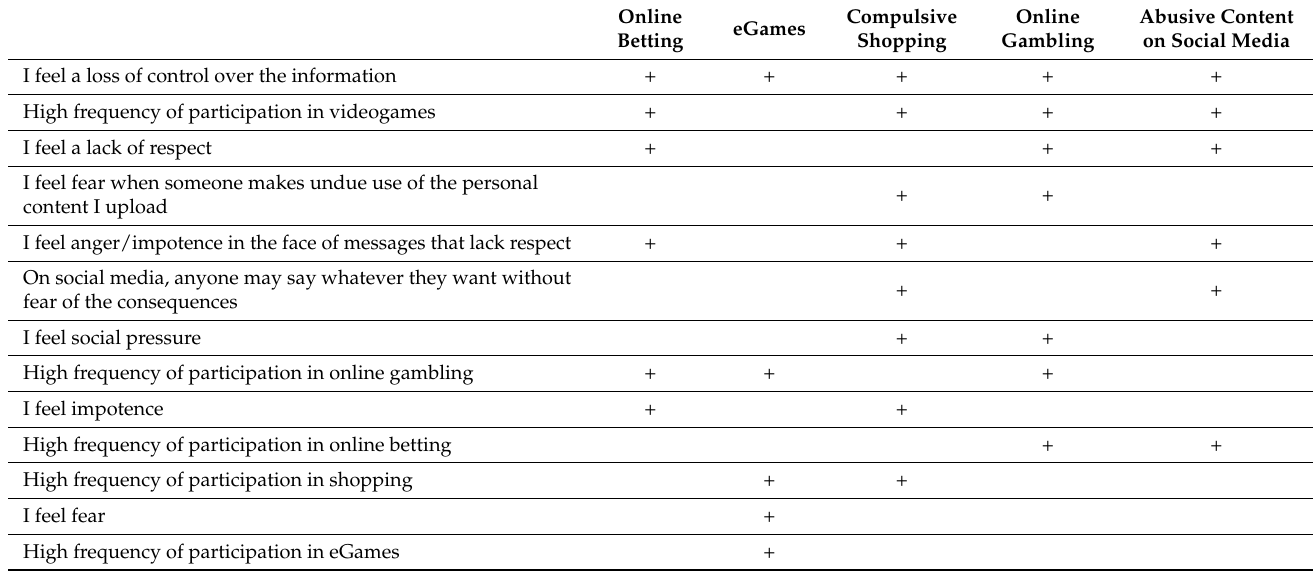
Table 7. Variables whose values indicating the presence of the value measured increase the probability of perceiving risk or danger in risky online activities.